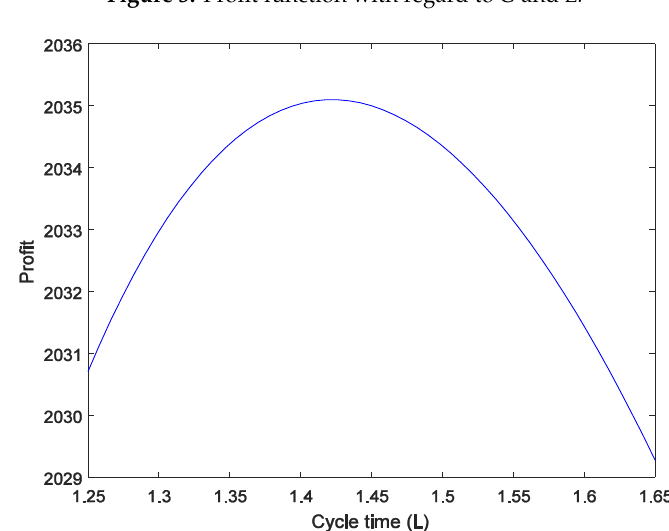
Figure 4. Profit function with regard to L.